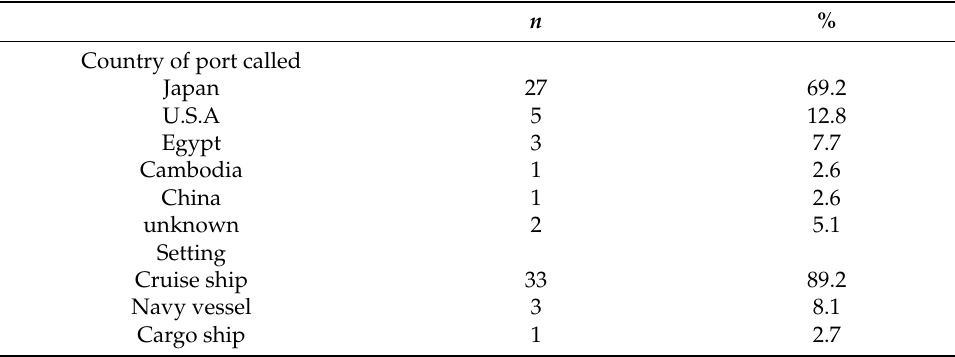
Table 2. Characteristics of the included studies in the systematic